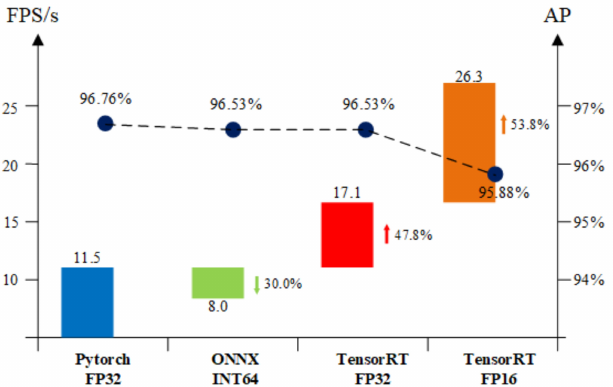
Figure 12. ShufflenetV2-YOLOX models for inference speed and AP accuracy on Jetson